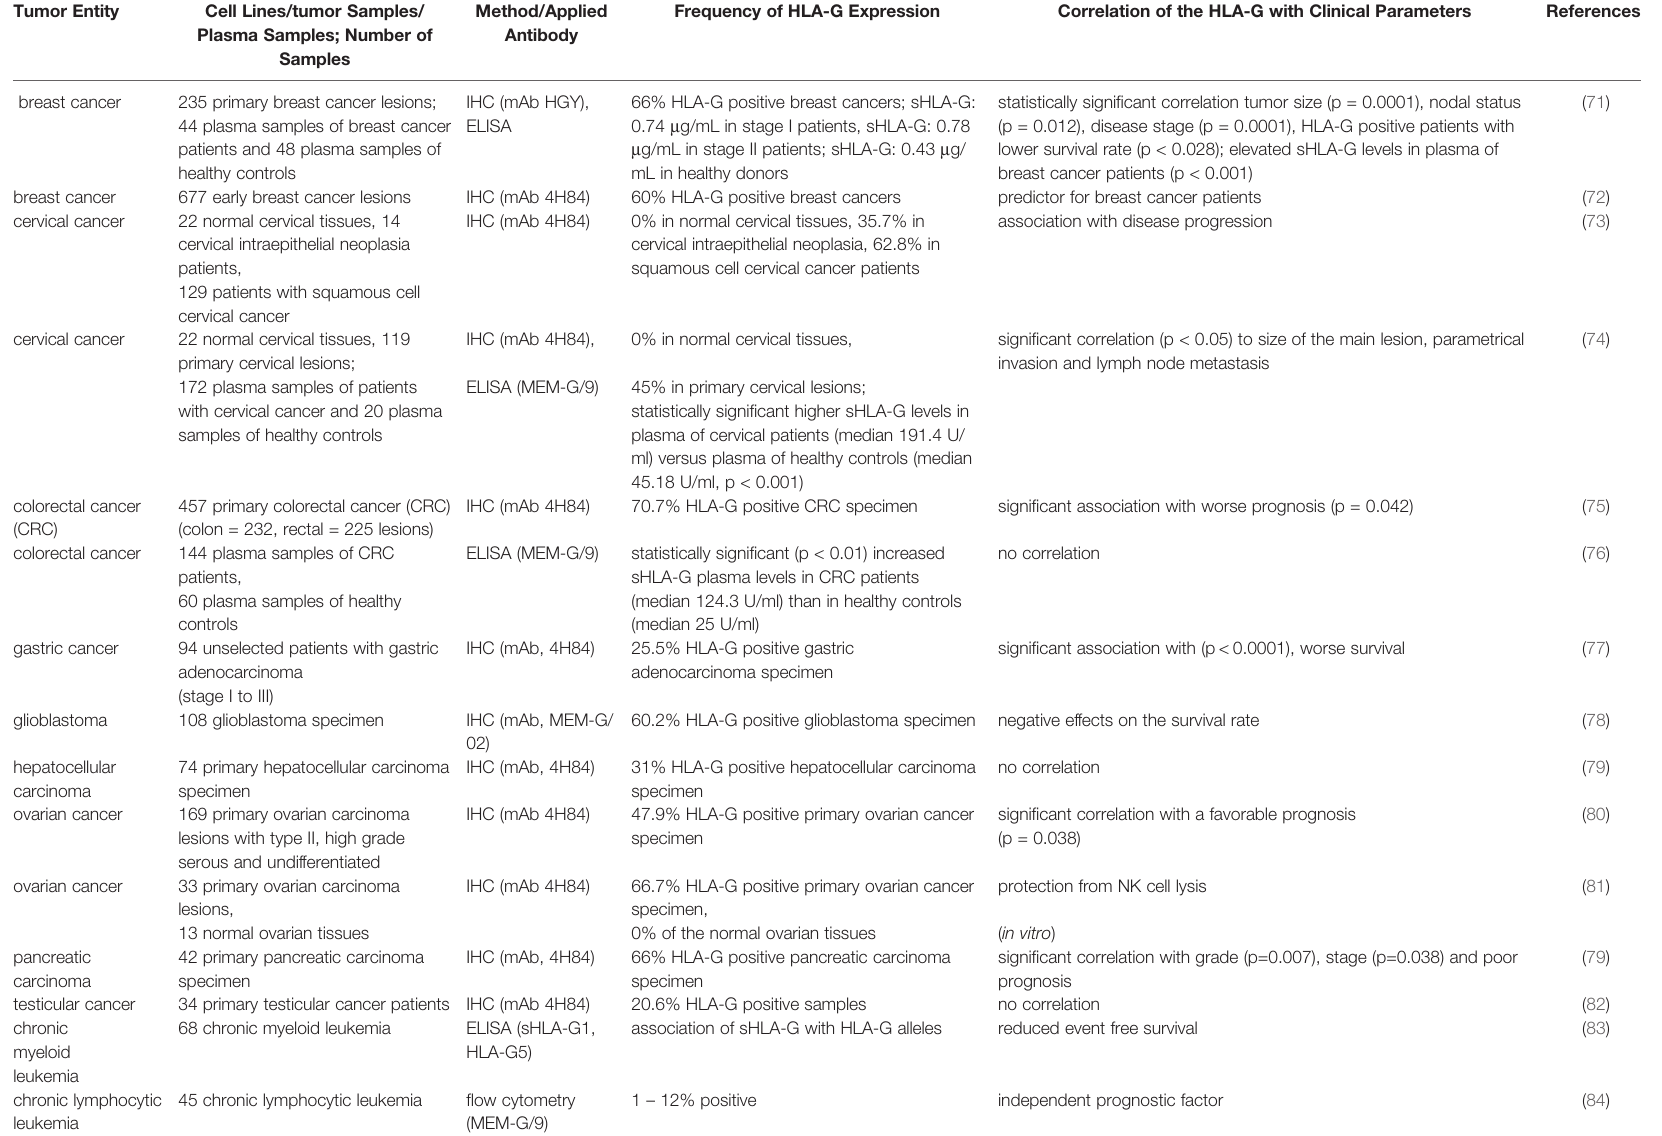
TABLE 2 | Summary of pathological HLA-G neoexpression in solid and hematopoietic malignancies. Tumor